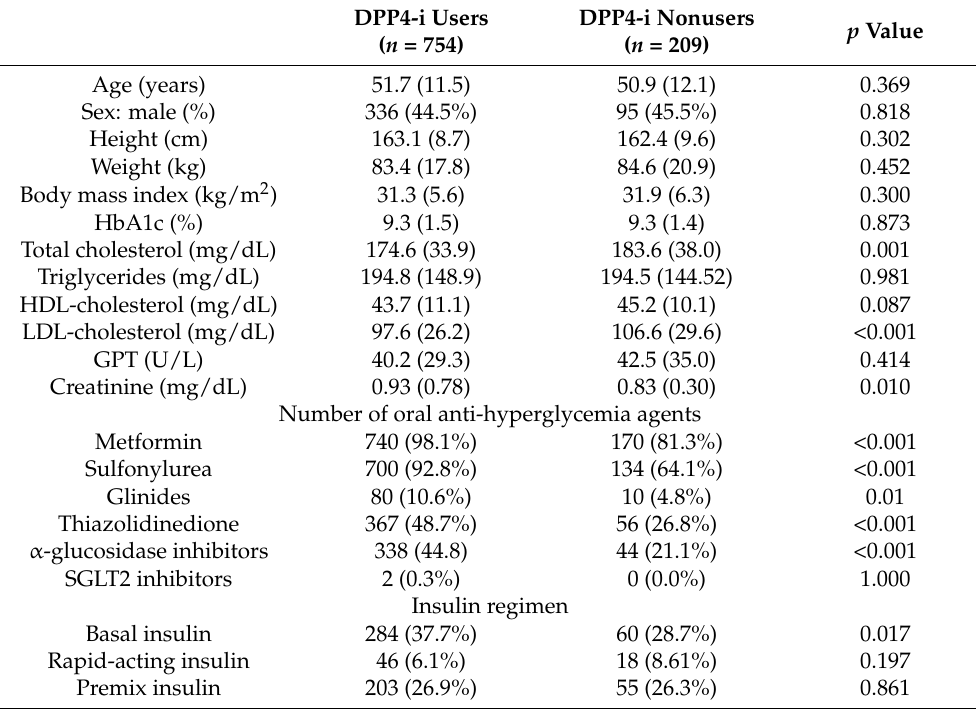
Table 1. Baseline characteristics of the study population before switching to GLP-1 RAs. Data are mean (SD), median (range) or n